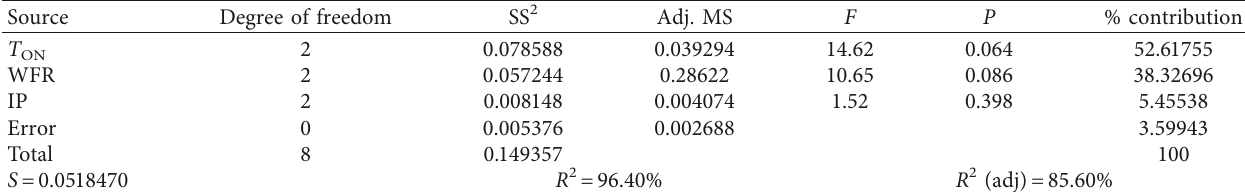
Table 11: ANOVA table for GFRG (after pooling).